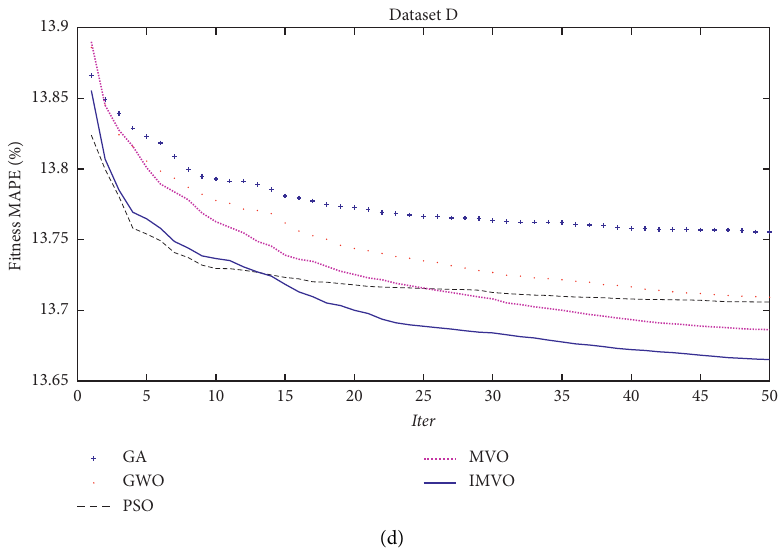
Figure 4: The average convergence curves of different intelligent optimization algorithms. (a) The average convergence curves of dataset A. (b) The average convergence curves of dataset B. (c) The average convergence curves of dataset C. (d) The average convergence curves of dataset